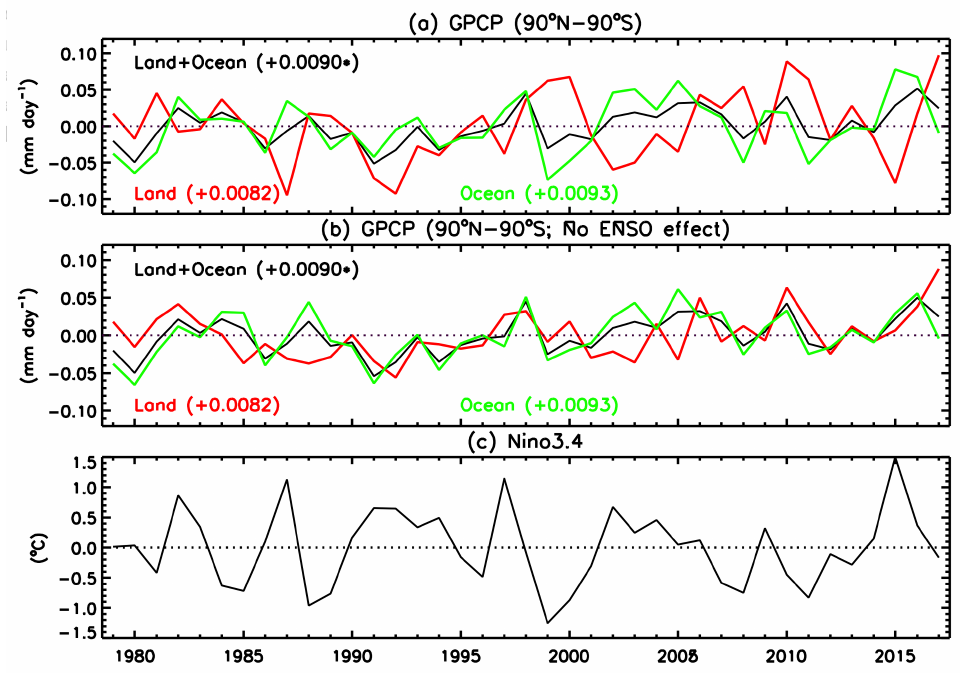
Figure 8. Time series of ( a ) global, annual mean precipitation anomalies, ( b ) ENSO effect removed, and ( c ) annual mean Niño 3.4. Also shown in ( a , b ) are corresponding linear trends (mm day − 1 decade − 1 ), and those followed by “ * ” are statistically significant.